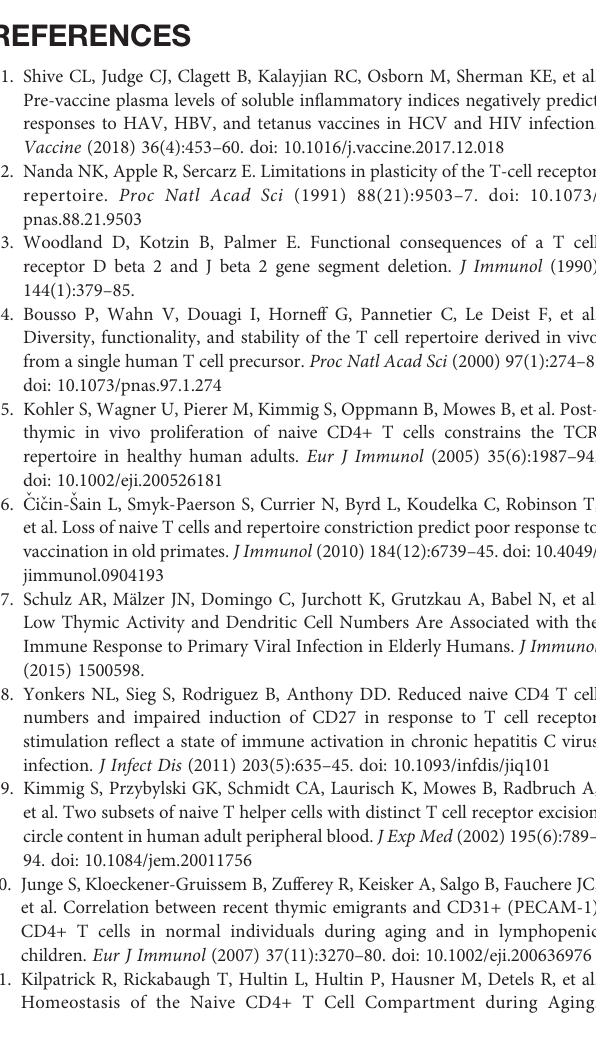
discuss whether we want p value for y axis intercept as well. The Linear regression test was used. Supplementary Figure 4 | The naïve CD4+CD31- T cells undergo spontaneous apoptosis at higher levels compared to the naïve CD4+CD31+ T cells before and after HCV DAA therapy and in absence of HCV infection. Magnetic bead puri fi ed (negative selection) naïve CD4 T cells from chronic HCV infected ( fi lled circles, n=4), HCV DAA-treated (open circles, n=4) and age-range matched uninfected control (stars, n=5) groups were stimulated with or without 10ng/ml of recombinant human IL-7 for 3 days. On third day, fl ow cytometric analysis for apoptosis (AnnexinV and 7AAD) on naïve (CD27+CD45RA+) CD4+CD31+ (A) and CD4+CD31- (B) T cells was performed. Mann Whitney test was used for comparisons between two groups; p= <0.05 considered signi fi cant. Supplementary Figure 5 | CD31 expression on naïve CD4+ T cells is mostly stable during in vitro stimulation with recombinant IL-7 or CD3/CD28 activator in cellsfromHCV infectedand DAA-treatedpersons. Magnetic beadpuri fi ed(negative selection) naïve CD4 T cells from chronic HCV infected ( fi lled circles, n=8; A, D ), HCV DAA-treated (open circles, n=8; B, E ) and age-range matched uninfected control (stars, n=7; C, F ) groups were stimulated with 10ng/ml of recombinant human IL-7 (A – C) or 1ul anti-CD3/anti-CD28 Activator (D – F) for 5 days. On 0 (direct ex vivo ), 3, and 5 days, fl ow cytometric analysis of CD31 expression on naïve (CD27+CD45RA+) CD4+ T cells was performed. Mann Whitney test was used for comparisons between two groups; p= <0.05 considered signi fi